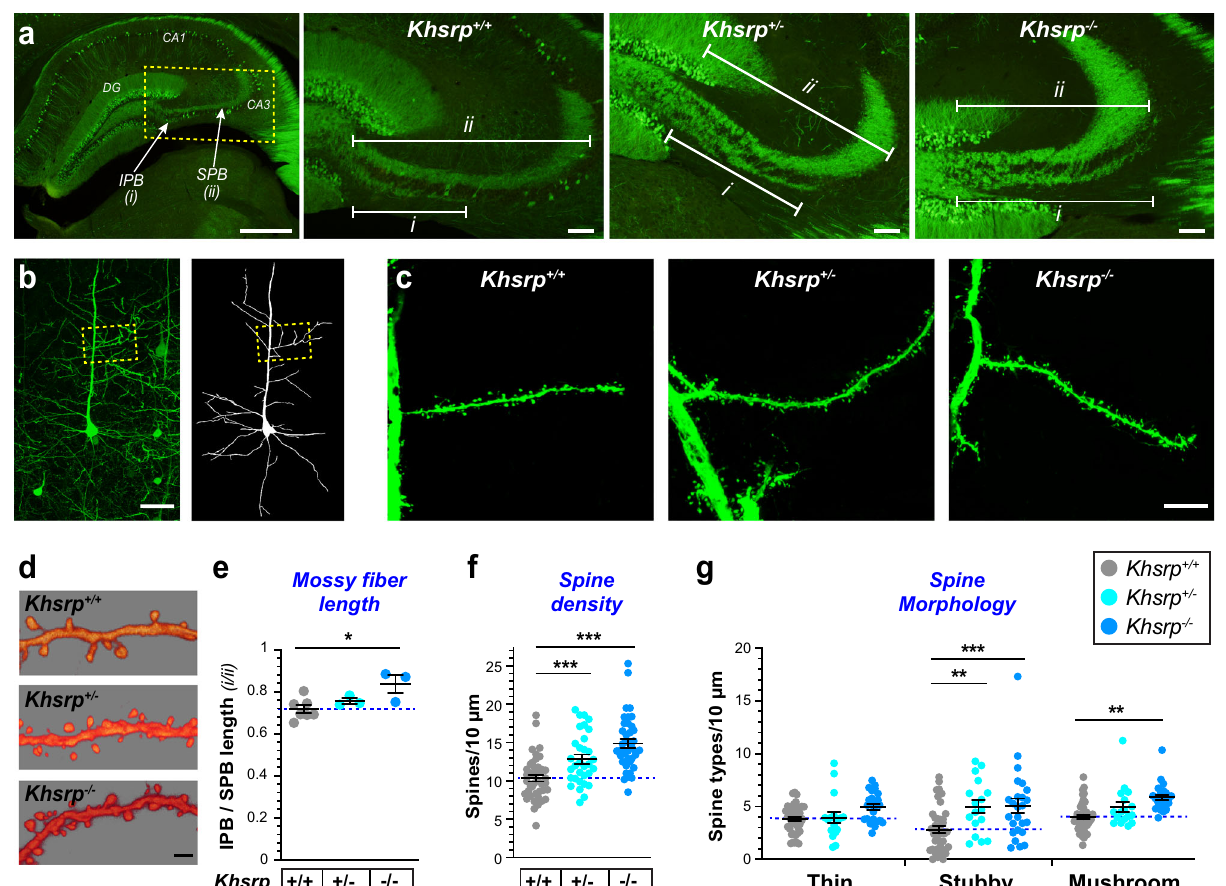
Fig. 2 Increased axon and dendrite growth in the brains of KHSRP de fi cient mice. a Representative images for hippocampi of adult mice for Thy1-GFP crossed with Khsrp + / − and Khsrp − / − show altered mossy fi ber outgrowth compared to Khsrp + / + . The low power image at left outlines area for three higher power images to the right. IPB is marked as ‘ i ’ and SPB as ‘ ii ’ in the three right panels (DG = dentate gyrus; CA1 and CA3 mark corresponding cornu Ammonis sub fi elds). b – d Panel ( b ) shows a low magni fi cation of confocal XYZ projection for layer 5 somatosensory cortex of Thy1-GFP × Khsrp − / − mice; left panel shows fl uorescent GFP signals and right panel shows Neurolucida tracing for a single neuron; boxed region shows approximate site for images of the secondary branches of apical dendrites shown in panels ( c , d ). Higher magni fi cation images of apical dendrite branches for Thy1-GFP mice crossed with Khsrp + / − and Khsrp − / − show that loss of KHSRP increases dendritic spine numbers in panels ( c ) and ( d ). e – g Mean IPB/SPB length (i/ii) ( e ) is signi fi cantly increased in Khsrp − / − compared to Khsrp + / + mice and spine density ( f ) is signi fi cantly increased in both Khsrp − / − and Khsrp + / − compared to Khsrp + / + mice. Density of stubby spines is signi fi cantly increased in both Khsrp − / − and Khsrp + / − while the density of mushroom spines is signi fi cantly increased in Khsrp − / − compared to Khsrp + / + mice ( g ). Error bars represent SEM ( N = 5; * p < 0.05 by ANOVA) [Scale bars = a left panel, 500 and right three panels 200 µ m; b 50 µ m; c 10 µ m; and d 2 µ